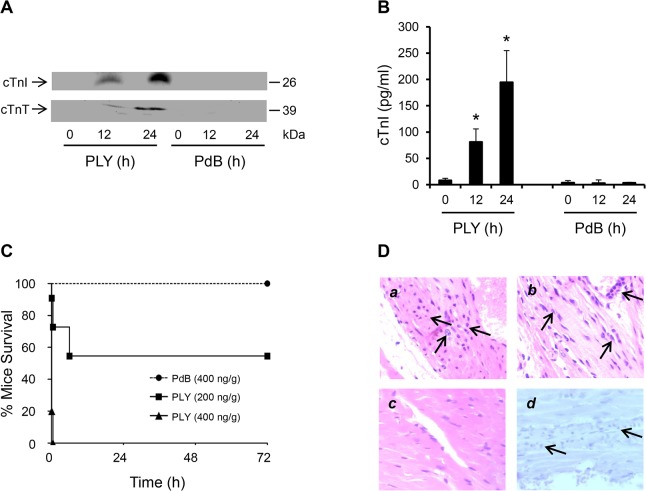
Circulating pore-forming PLY mediates cardiac injury and inflammation in vivo.(A) Representative Western blots showing circulating cTnI and cTnT in murine plasma following i.v. injection of PLY (200 ng/g) and PdB (400 ng/g). (B) Mean±SD of circulating cTnI from 4 mice (each group) that survived at 24 h after treatment with PLY and PdB. *p<0.05 as compared to PdB group. (C) Survival curves of mice injected (i.v.) with PLY (400 and 200 ng/g) or PdB (400 ng/g) (n = 8 each group). (D) Pathological examination of murine heart sections after infection with purified PLY (200 ng/g) (a, b and d) and PdB (400 ng/g) (c). H&E representative images (a-c) of murine heart sections under x60 magnification showing inflammatory cell infiltrations (arrows) in mice dying within 6 hours (a) and those surviving for 24 hours (b). (c) PdB injection causes no pathological abnormality in murine myocardium. (d) Absence of active caspase-3 staining in murine myocardium following PLY injection.